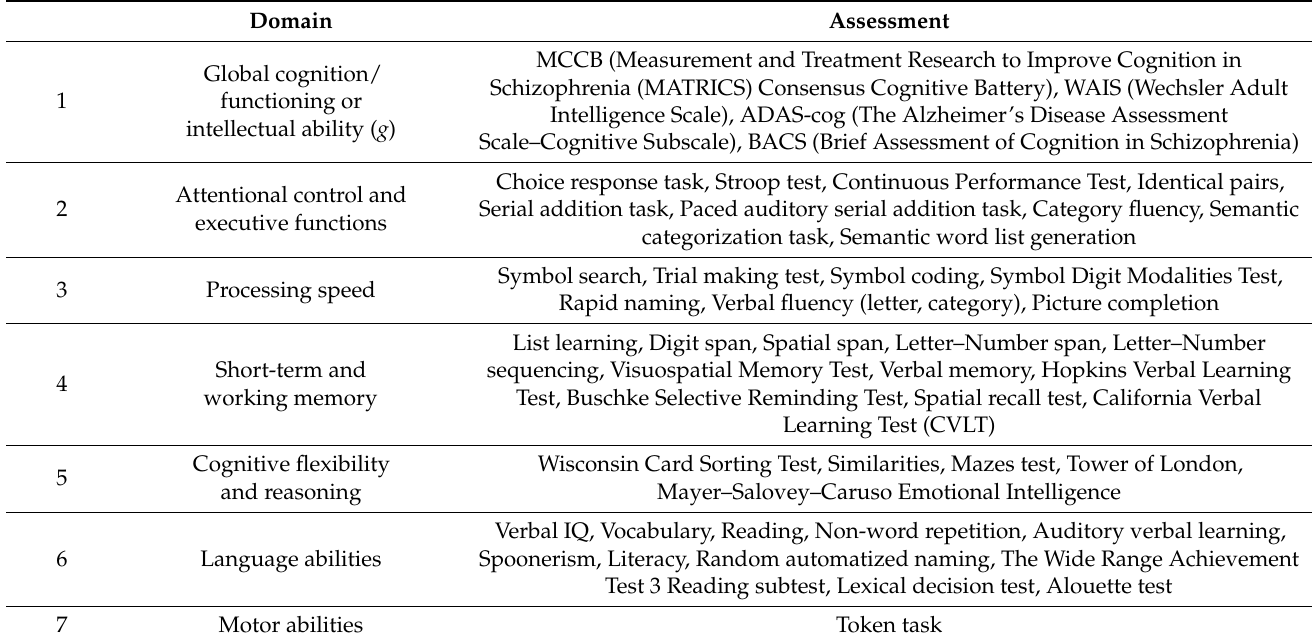
Table 2. The neurocognitive tasks/measures used in the included studies, grouped by